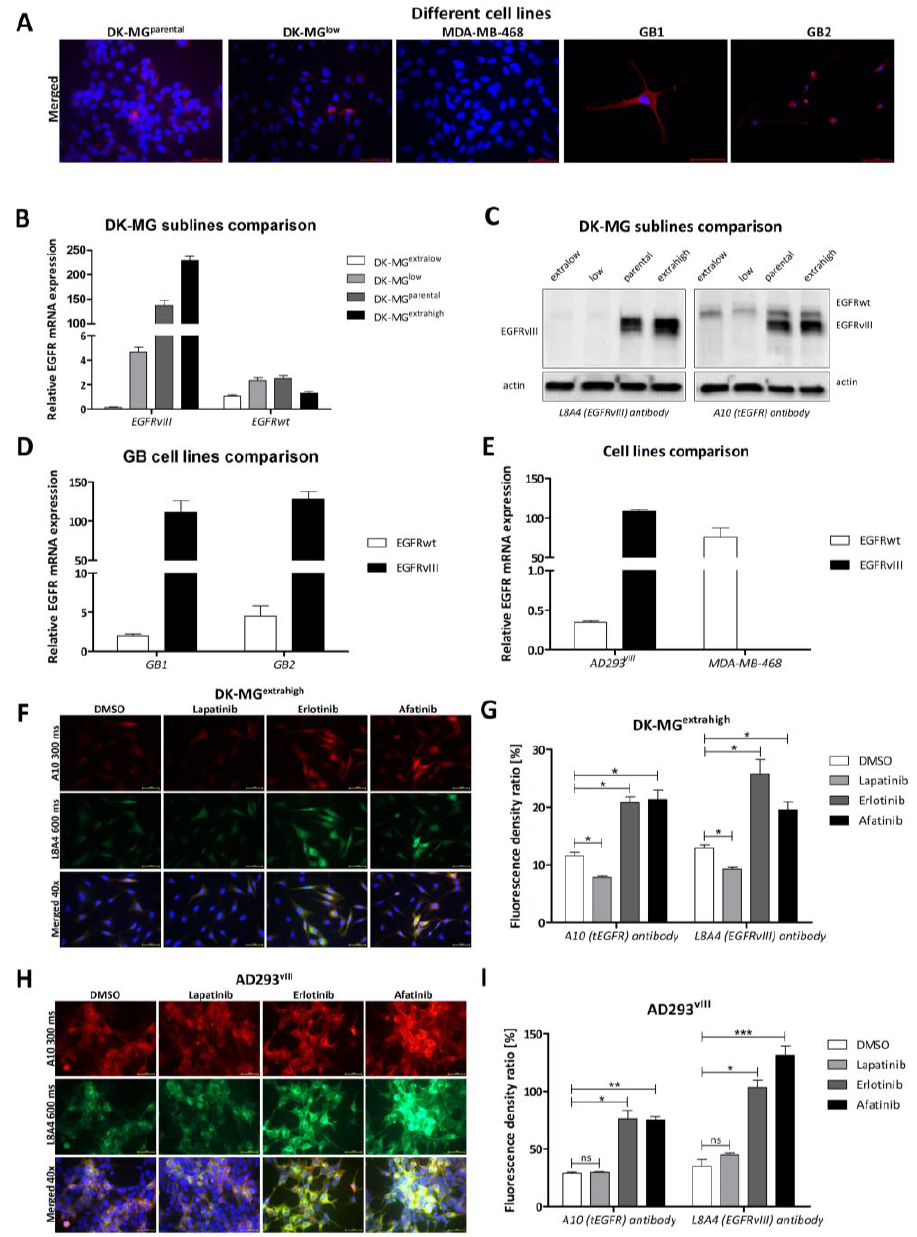
Figure 1. Characterization of research model according to different EGFRvIII expression profiles. ( A ) The cell lines DK-MG parental , DK-MG low , MDA-MB-468, and primary GB1 and GB2 culture were selected for testing L8A4 specificity in recognition and binding to the EGFRvIII epitope. For this purpose, cells were immunocytochemically stained with mouse L8A4 antibody (red) ( A ). There was no positive signal in the case of MDA-MB-468 cells, in which there is no EGFRvIII expression. About 5–10% and 50% of DK-MG low and DK-MG parental cell populations, respectively, interact with the L8A4 antibody, which corresponds with their profile of EGFRvIII expression. Specific binding of the antibody was also observed in primary GB cultures, with a previously confirmed expression of EGFRvIII. Taken together, these results demonstrate that the L8A4 antibody specifically recognizes EGFRvIII. Observations were performed under 40 × magnification, except for GB2-20x, for the following exposition times: DAPI, 10 ms; L8A4, 600 ms. ( B , C ) Confirmation of EGFR (wt and vIII) expression levels in extralow, low, parental, and extrahigh DK-MG sublines performed at both mRNA ( B ) and protein ( C ) levels. Results for real-time PCR of ( D ) GB1 and GB2 and ( E ) MDA-MB-468 compared with AD293 vIII . ( F , G ) The influence of particular TKIs (10 µM erlotinib, 0.5 µM afat- inib, and 10 µM lapatinib) on total EGFR amount was investigated by immunocytochemical staining